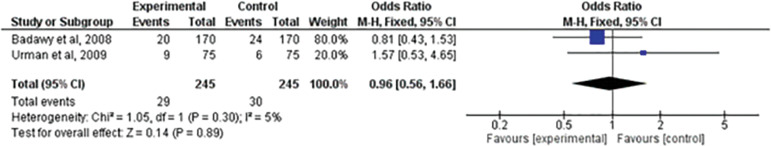
Forest-plot of premature birth incidence with treatment